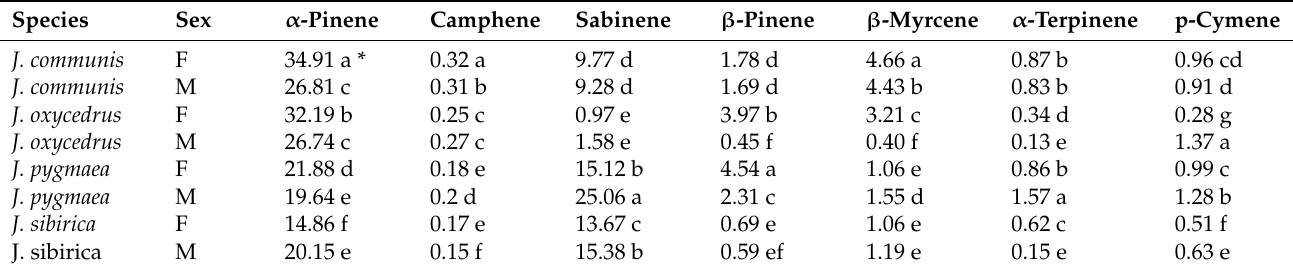
Table 2. Mean concentration (%) of α -pinene, camphene, sabinene, β -pinene, β -myrcene, α -terpinene, and p-cymene (extracted using the commercial steam extraction method) obtained from the eight combinations of species and sex. Species Sex α -Pinene Camphene